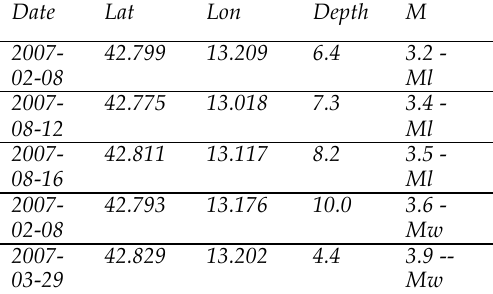
Table 2. 2007 Castelluccio data from INGV Catalogs,